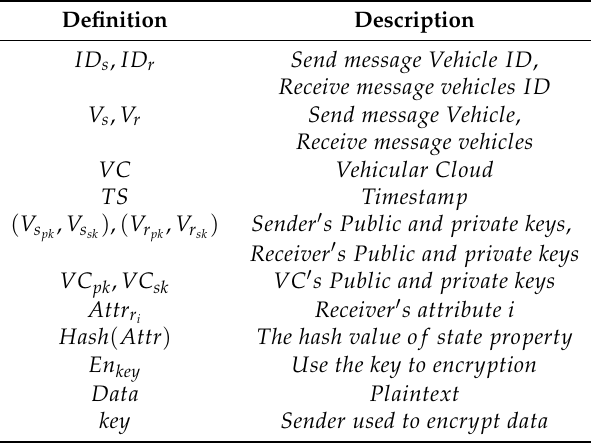
Table 1 defines the main parameter symbols used in this article. Table 1. The main symbol